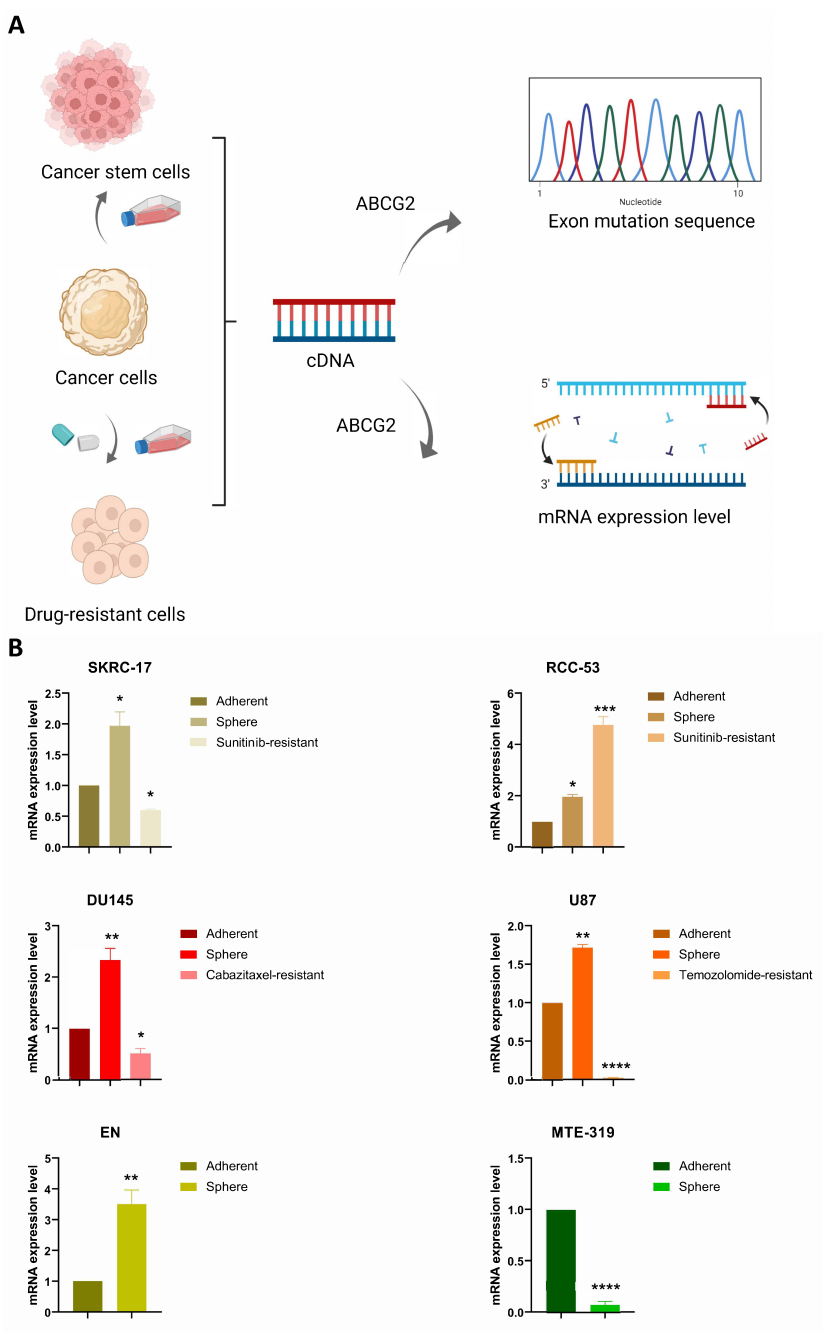
Figure 12. The detection of ABCG2 gene in cancer cells, cancer stem cells, and corresponding drug resistant cells: ( A ) Workflow of cell line preparation and exon sequencing of the ABCG2 gene; ( B ) RT-qPCR analysis representing relative mRNA expression levels of ABCG2 in various cancer cell lines and their corresponding sphere and drug-resistant cell lines. * p < 0.05, ** p < 0.01, *** p < 0.001, **** p <